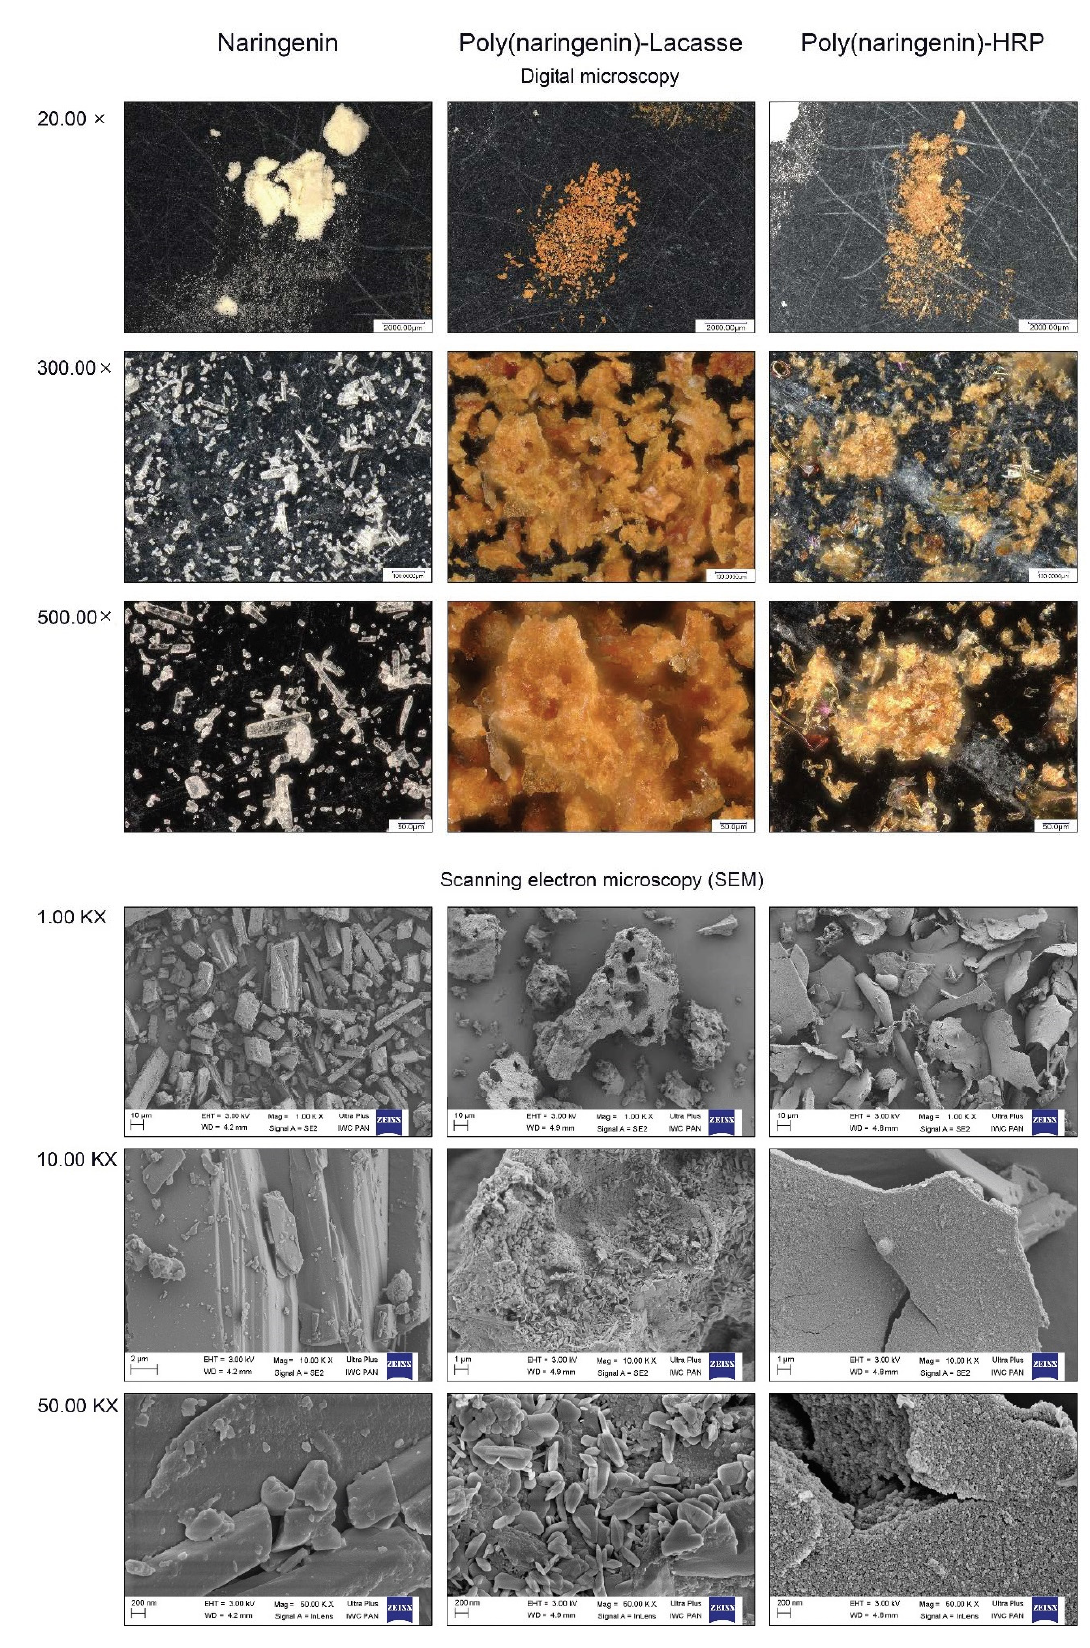
Figure 5. Digital images (20×, 300×, 500× magnification) and SEM images (1.00 kx, 10.00 kx and 50.00 kx magnification) of naringenin, poly(naringenin)-laccase and poly(naringenin)-HRP.